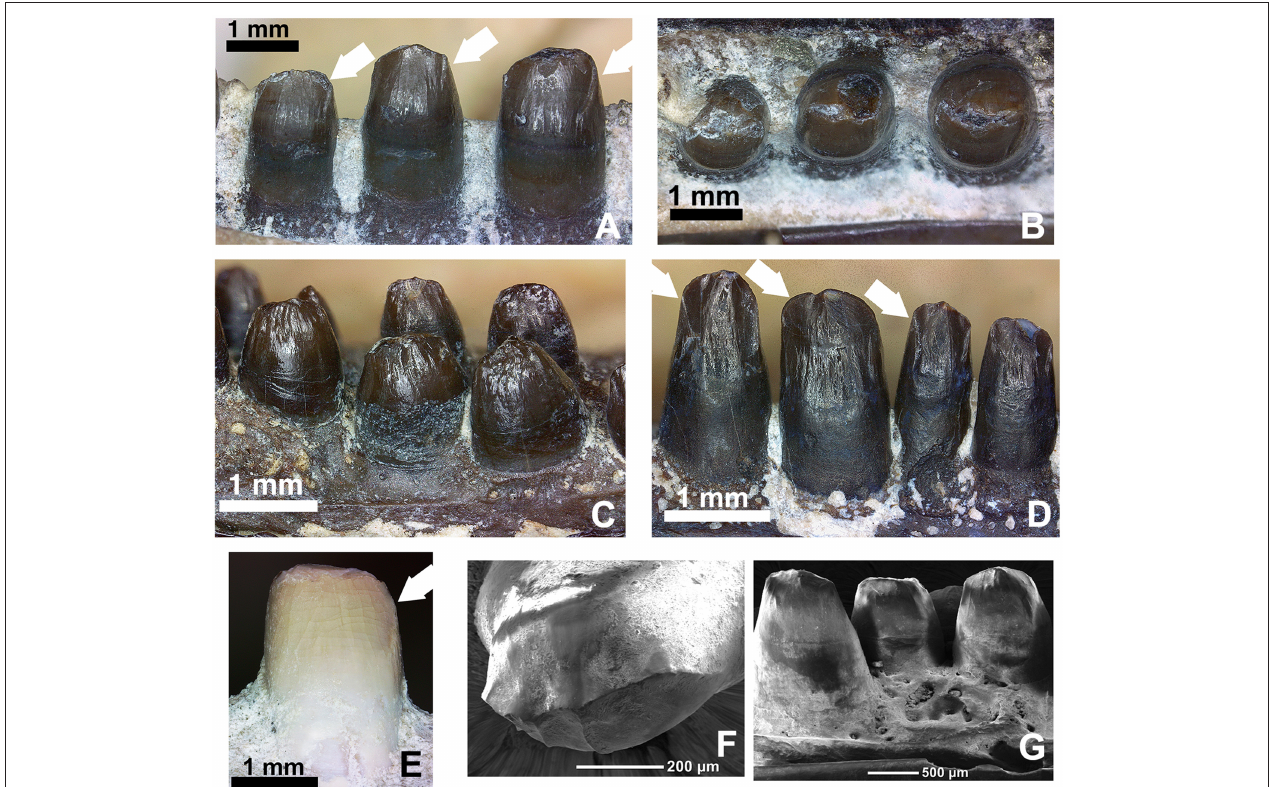
FIGURE 13 | Comparison of the dentition in the mid-dentary region of various members of the genus Captorhinus . (A,B) OMNH73281a—Lingual and occlusal views of the left dentary teeth of Captorhinus kierani . Tooth positions right to left are 6, 7, and 8. White arrows indicate the position of the descending antero-mesial ridge. Note the nearly circular shape of tooth # 6 (far right) when exposed in occlusal aspect. (C,D) Close-up view and comparison of the marginal dentition from two uncatalogued, isolated jaw fragments. The specimen on the left is representative of the generally accepted ogival form that is characteristic of Captorhinus aguti , with short somewhat bulbous teeth. The specimen on the right displays taller teeth, which more closely resemble the dentition seen in C. kierani . It is likely that the teeth shown in the latter image do not represent C. aguti , even with the presence of what appears to be an additional tooth row (refer to Figure 14B for image of entire jaw fragment). Note the presence of the descending antero-mesial ridge on the crown of the specimen—denoted by white arrows, as found on the teeth of C. kierani and to a much lesser degree C. magnus . (E) OMNH56821. Mesial view of 7th dentary tooth of C. magnus . Note the relatively smooth surface with only a very fine ridge along the antero-mesial surface of the crown. This ventrally directed ridge is much more well developed in C. kierani . (F,G) SEM micrographs of C. aguti teeth. LEFT—Occlusal view of dentary tooth ( C. aguti ) & RIGHT—Lingual view of dentary teeth ( C. aguti ). Note the enamel boundary separating the exposed tooth crown from the gum-line and the descending ridges along the mesial surface—notably on the tooth seen on the image on the left.